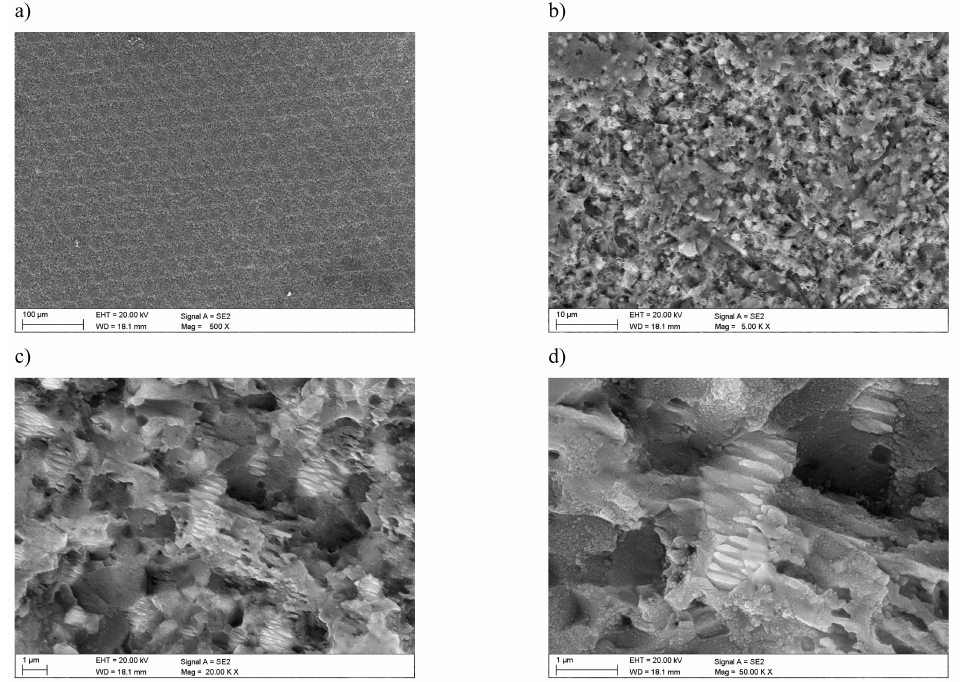
Figure 5. Laser microstructure on sialon tool ceramics: ( a ) area 500 × , ( b ) area 5000 × , ( c ) area 20,000 × , and ( d ) area 50,000 ×